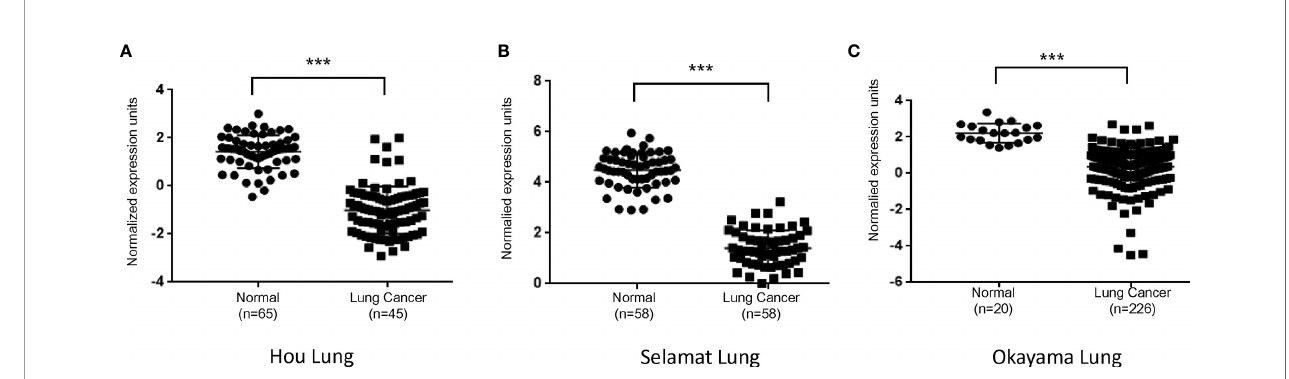
FIGURE 1 | PLAC9 mRNA levels are reduced in lung cancer samples compared to normal tissue samples. PLAC9 mRNA expression in lung adenocarcinomas and paired adjacent normal tissues from three independent lung cancer studies (Hou Lung, Selamat Lung, and Okayama Lung, in A – C , respectively) were obtained from the Oncomine database and plotted individually. (*** p value